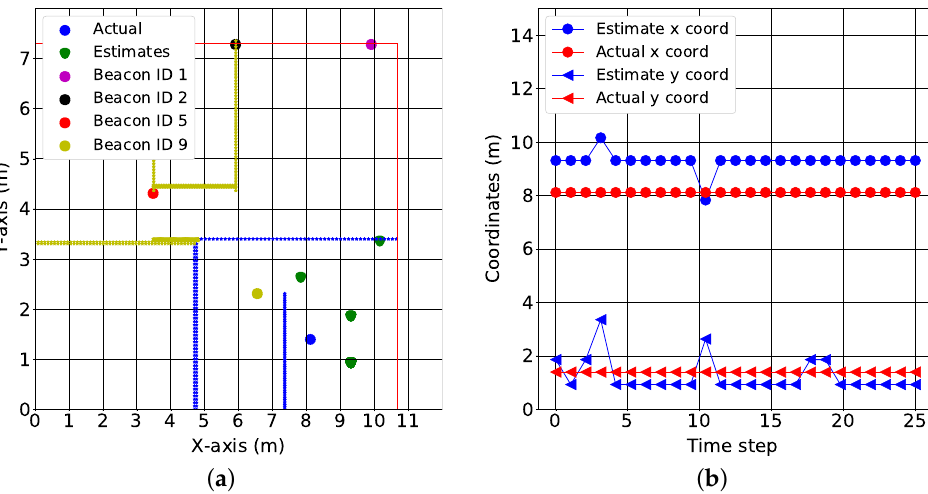
Figure 16. Testing in the dining room. ( a ) Floor plan view, and ( b ) location estimates over time.